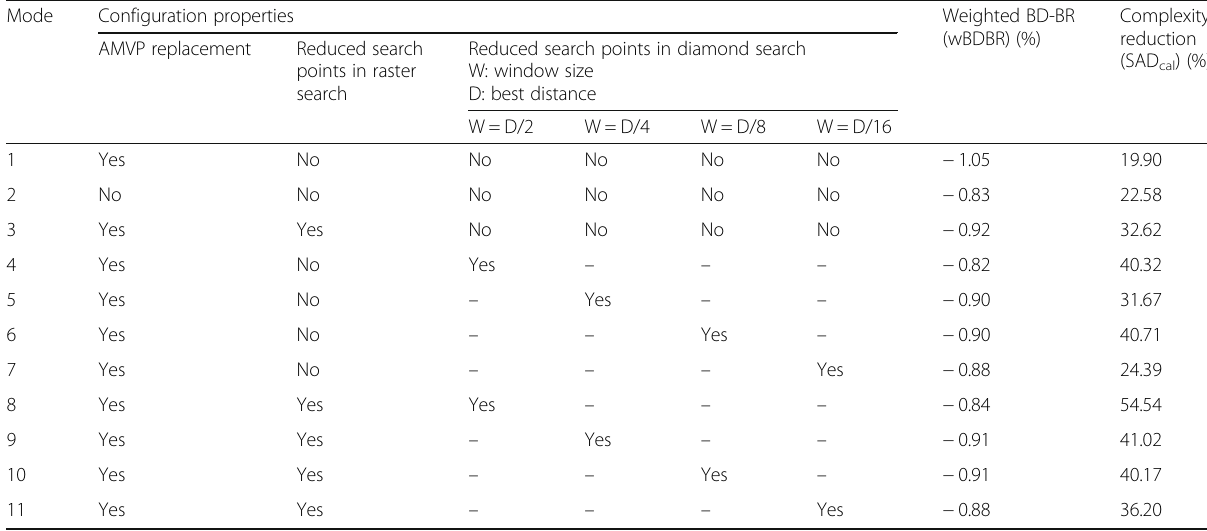
Table 2 Various configurations of the proposed algorithm Mode Configuration